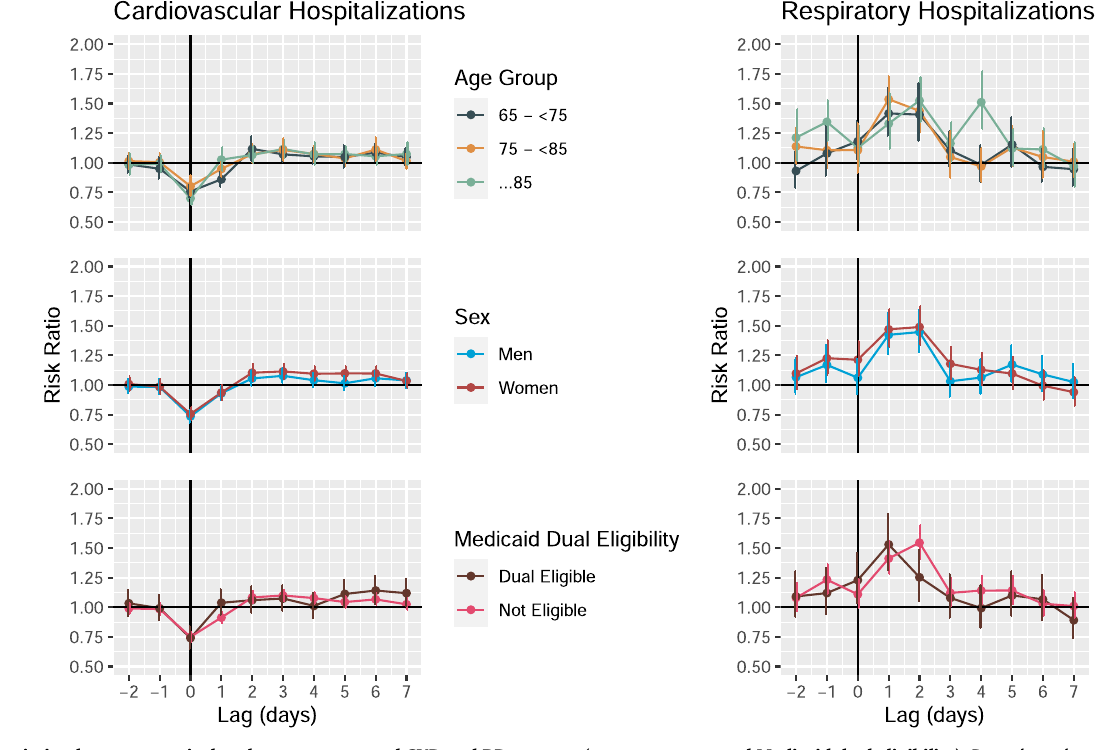
(age group, sex, and Medicaid dual eligibility). Dots show the point estimates and error bars represent 95% con fi dence intervals. Source data provided as a Source Data fi